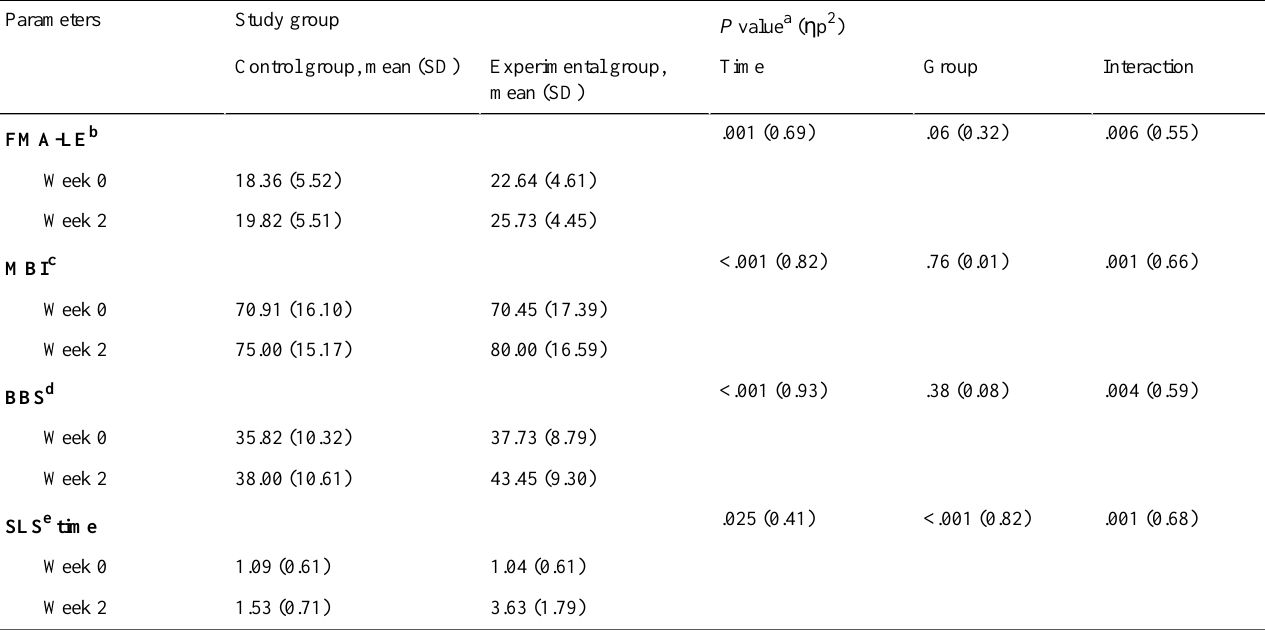
Table 4. Main effect of time, group, and time-group interaction of the intervention on the outcome measures by repeated-measures analysis of variance with a Greenhouse-Geisser